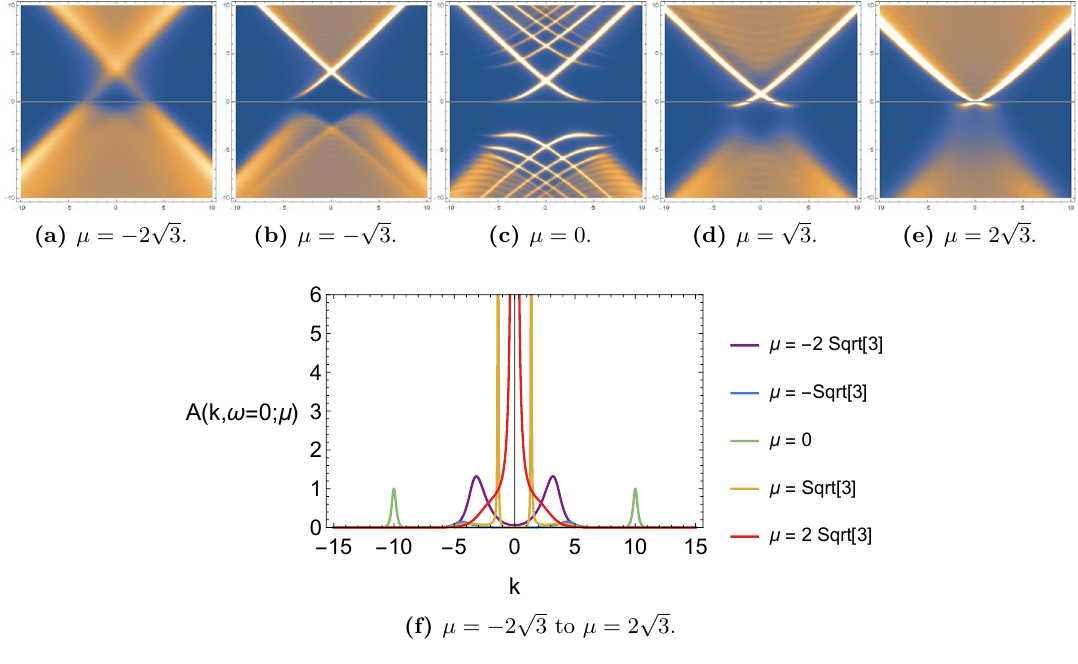
= 7 . (a,b,c,d,e): denisity rt (0)